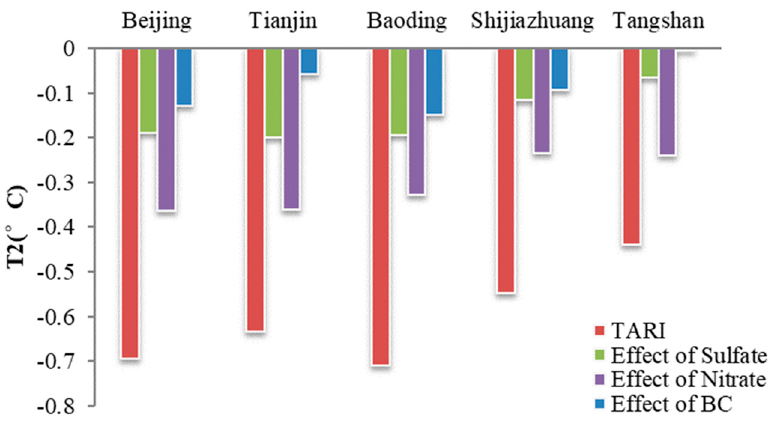
Figure 8. Simulated results of ARI e ff ects under di ff erent particulate matter components on T2.